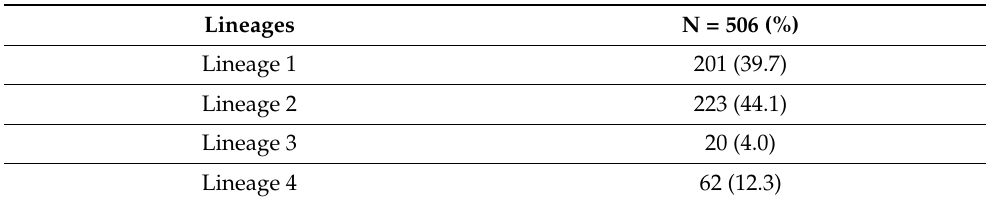
Table 2. Distribution of lineages.